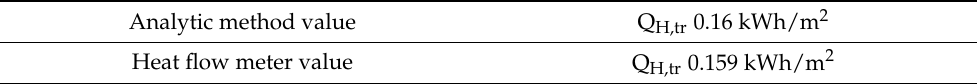
Table 12. Post operam energy losses by transmission through wall (Q H,tr